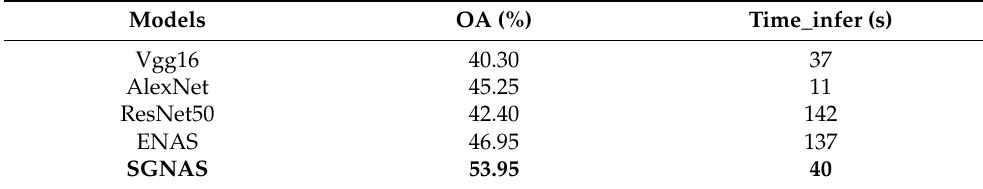
Table 3. Overall accuracy and inference time of the cross-domain scene classification of different models for SIRI-WHU → RSSCN7.